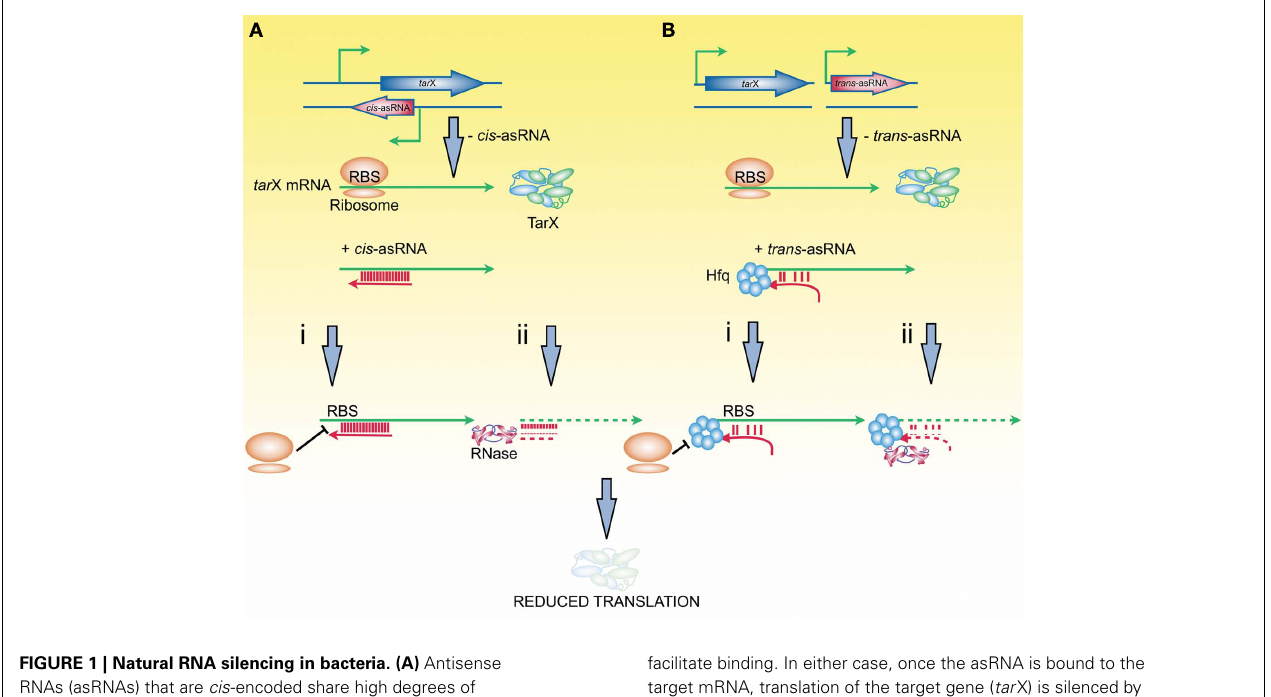
FIGURE 1 | Natural RNA silencing in bacteria. (A) Antisense RNAs (asRNAs) that are cis -encoded share high degrees of complementarity with the target mRNA. (B) asRNAs that are trans -encoded have limited complementarity with the target mRNA and, in some species, require the an RNA chaperone (Hfq) to